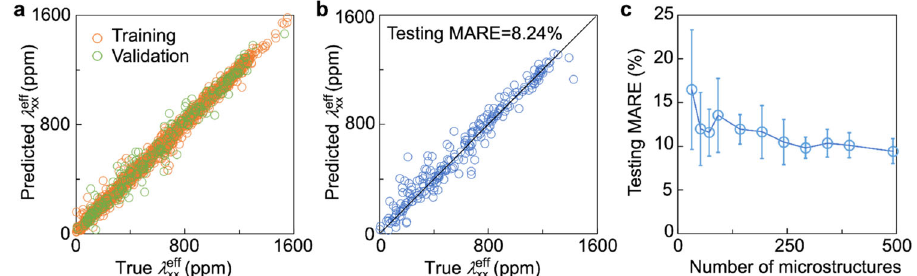
The sixth sentence of the fi rst paragraph of the “ Property prediction by the GNN model ” section originally stated “ The MARE for these data is as low as 8.05% ” . In the corrected version, “ as low as 8.05% ” is replaced by “ as low as 8.24% ” . The tenth sentence of the fi rst paragraph of the “ Property prediction by the GNN model ” section originally stated “ As shown in Fig. 4c, the average value of the MARE quickly decreases from 17% to ~10% ” . In the corrected version, “ 17% to ~10% ” is replaced by “ ~16% to ~ 12% ”